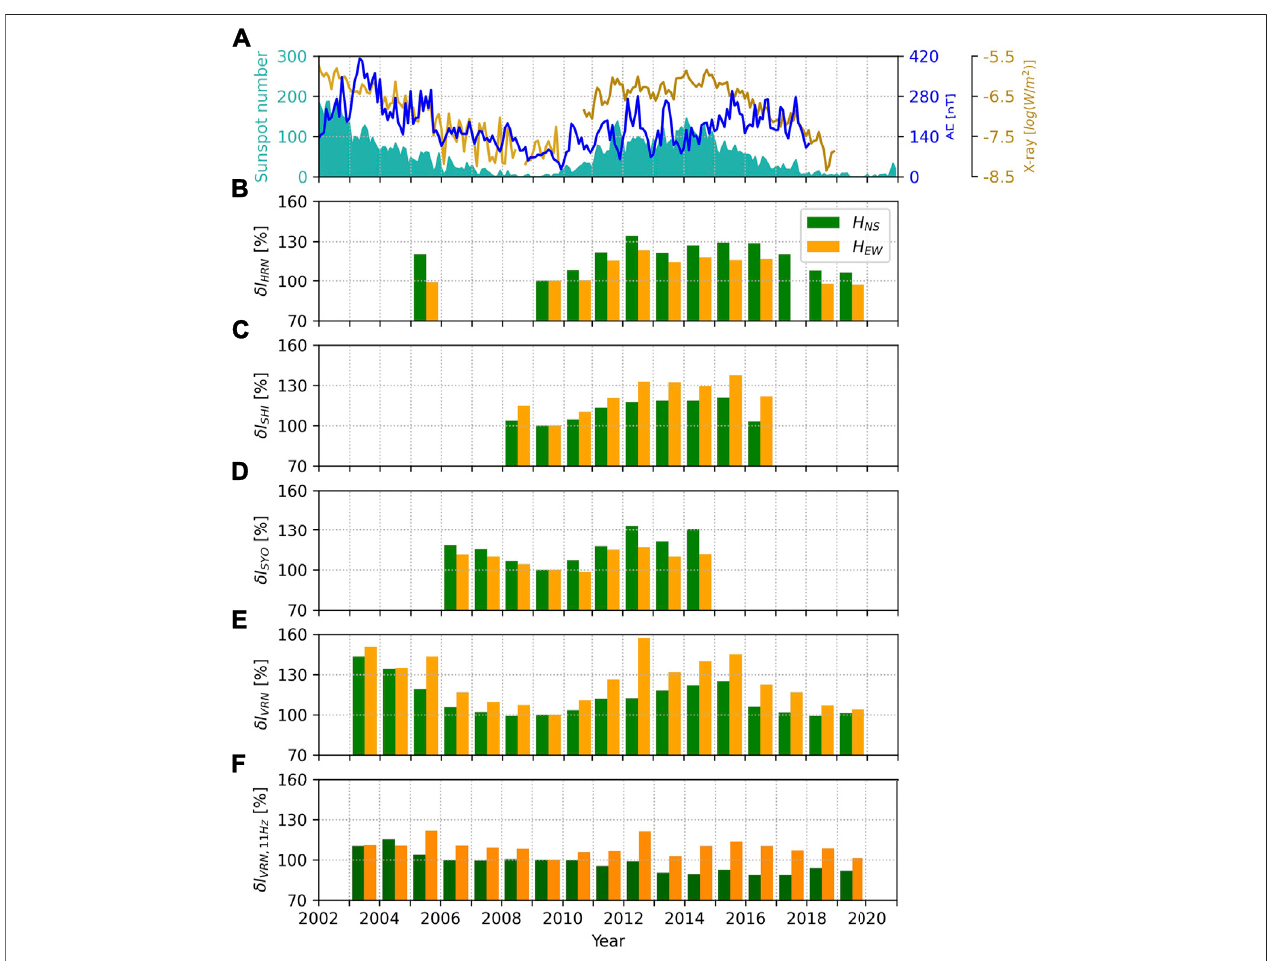
FIGURE 5 | (A) Monthly average values of the sunspot number (turquoise), the AE index (blue) and the X-ray fl ux (GOES-10: gold, GOES-15: dark gold) as well as thenormalizedyearlyaveragesofthe fi rstSRmode ’ sintensityat the (B) HRN, (C) SHI, (D) SYOand (E) VRN stationsand (F) oftheintensityat 11 HzattheVRN station.